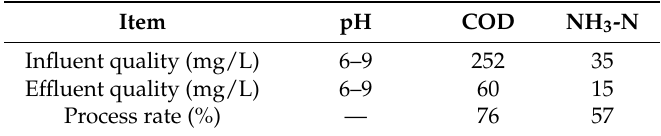
Table 2. The designed influent and effluent quality and pollutant removal rate of the sewage plant.